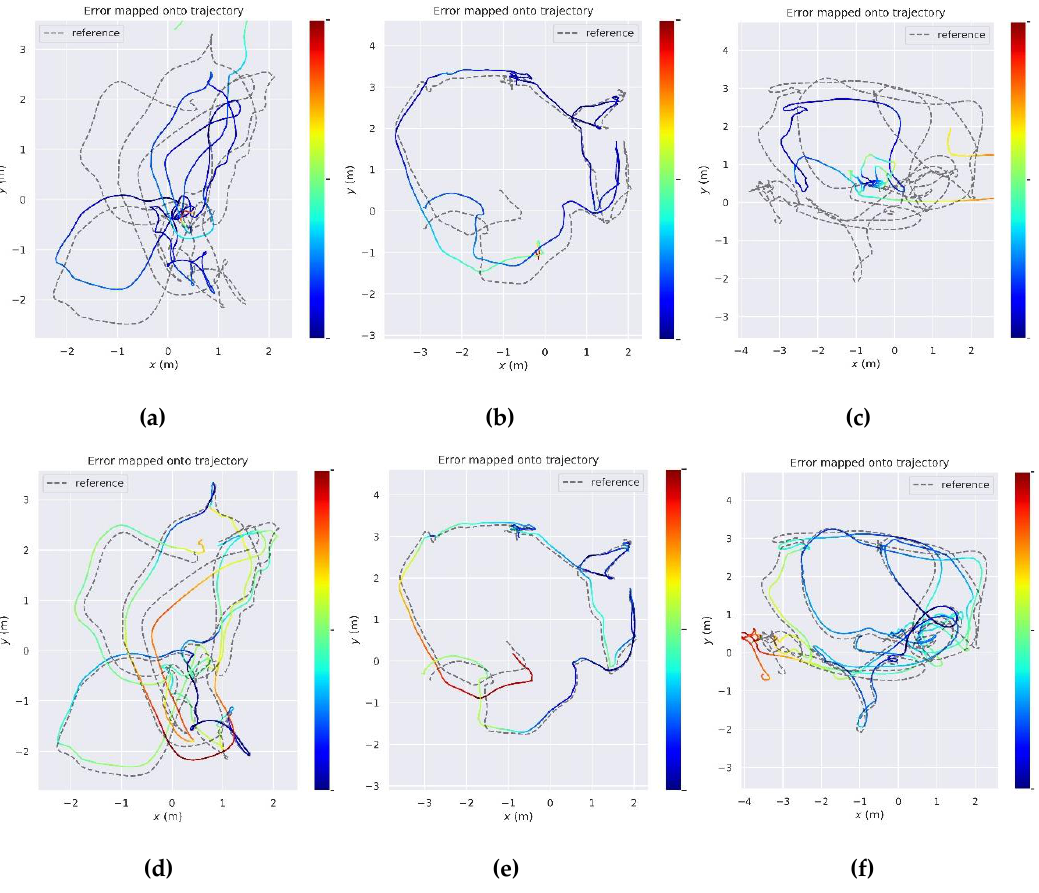
Figure 11. Heat maps of the positioning trajectory of Dynamic-DSO and DSO in three sequences. ( a ), ( b ), ( c ): Positioning results of DSO in V101_syn, V201_syn and V202_syn respectively. ( d ), ( e ), ( f ): Positioning results of Dynamic-DSO in V101_syn, V201_syn and V202_syn respectively.